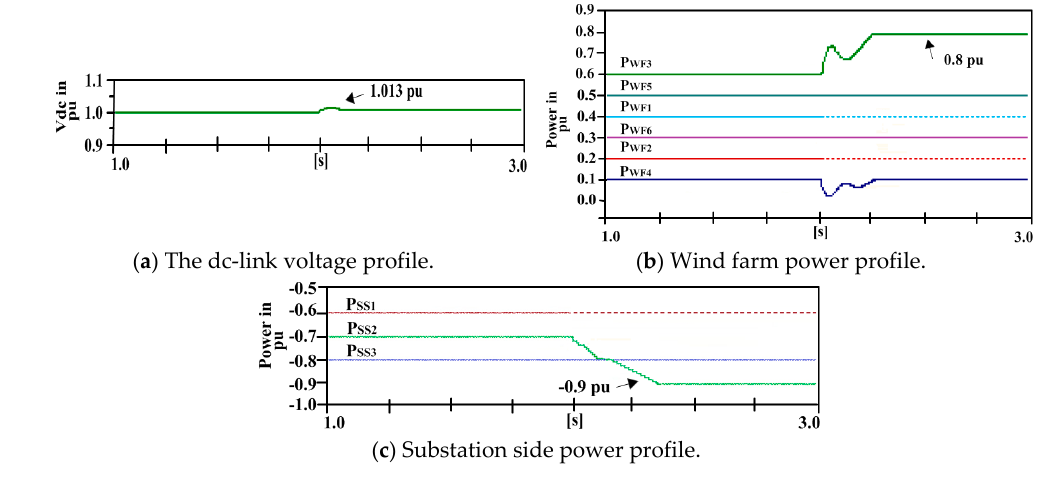
Figure 11. Disconnection of GS-VSC 1 from the 2WF-1SST.